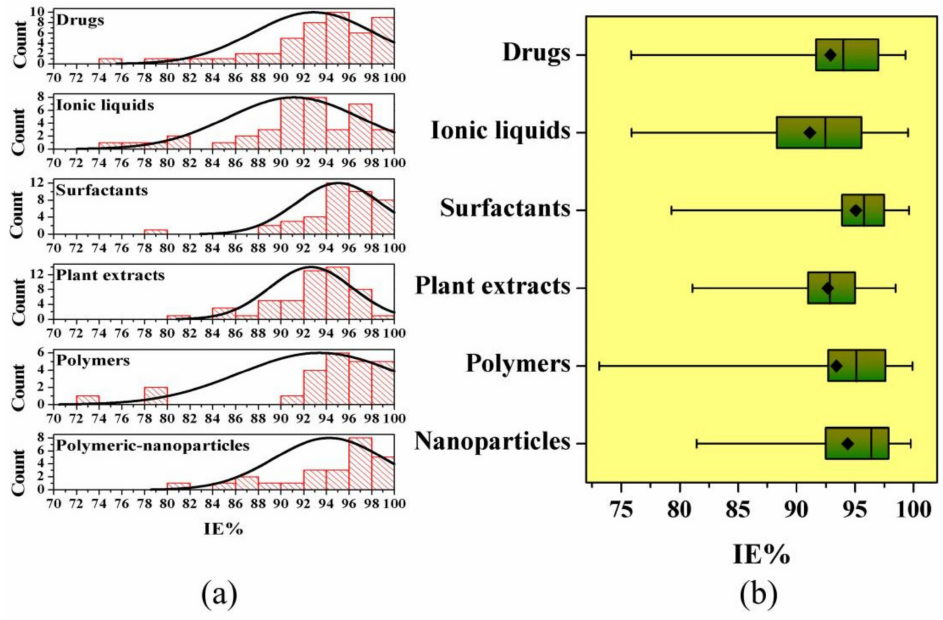
Figure 17. ( a ) Histogram of maximum inhibition efficiency values for six kinds of inhibitors, ( b ) box-whisker plots of maximum inhibition efficiency values for six kinds of inhibitors, the source of the data is in Supplementary Tables